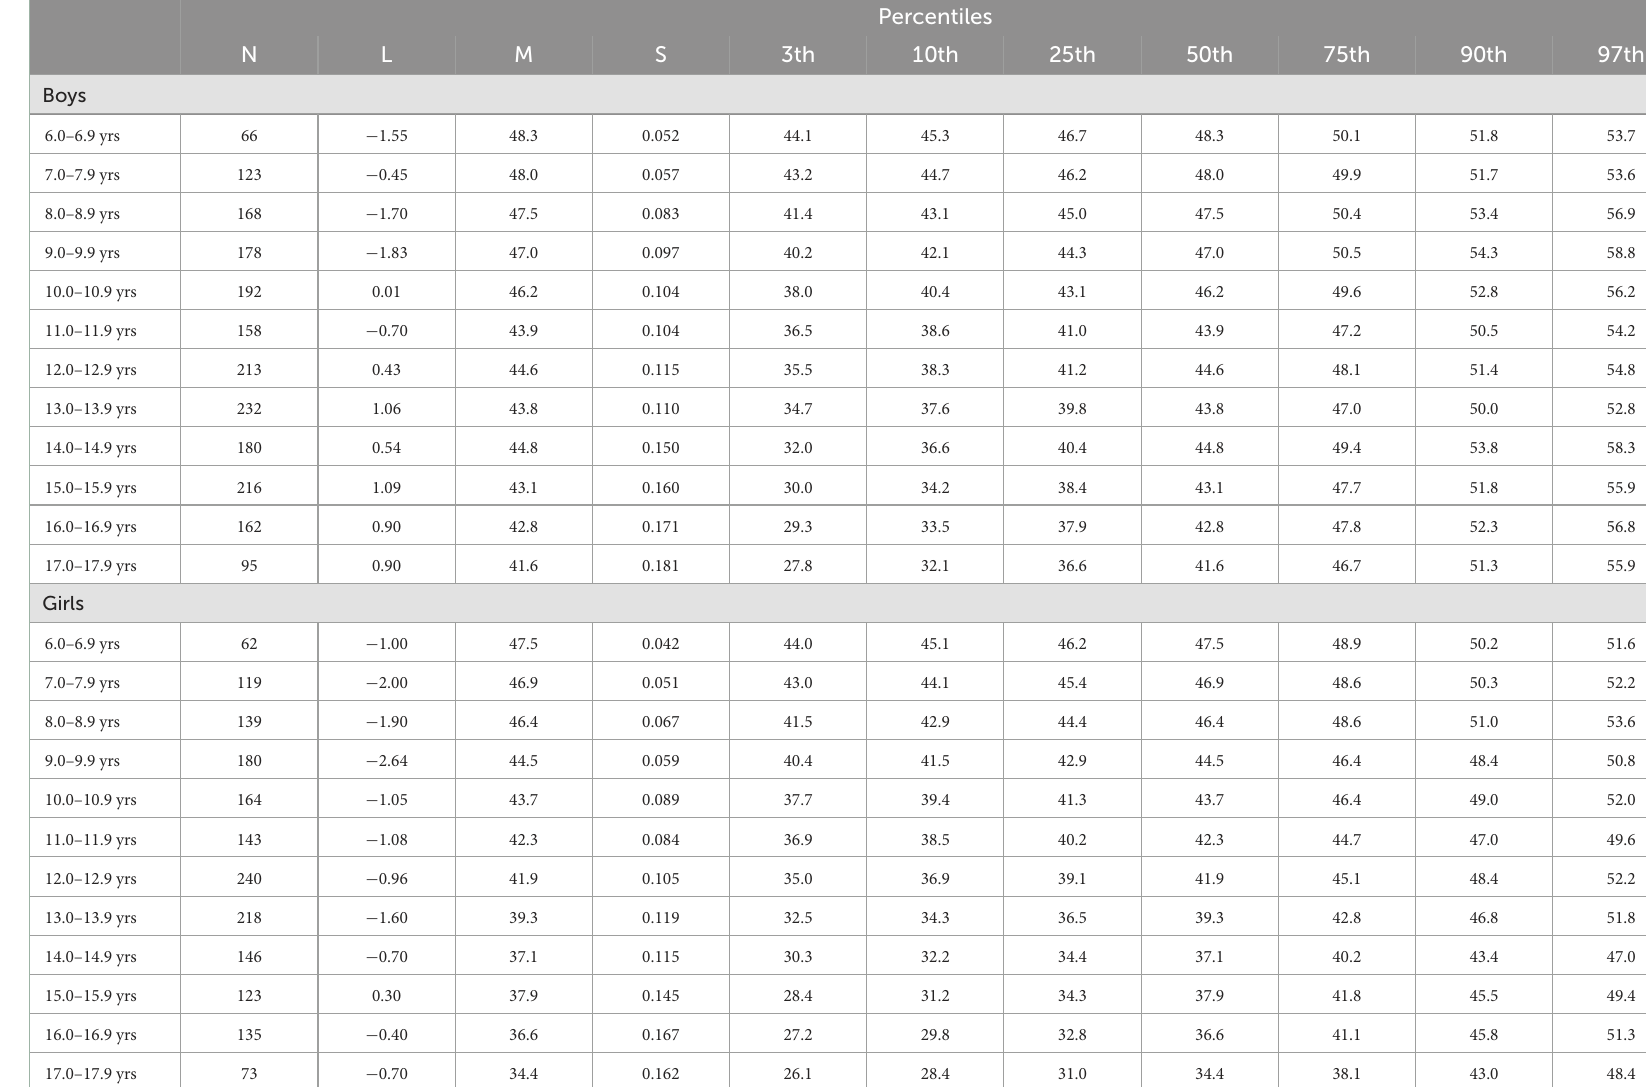
TABLE 2 Percentile references values for VO 2 max according to age and gender in Québec children and adolescents (N =